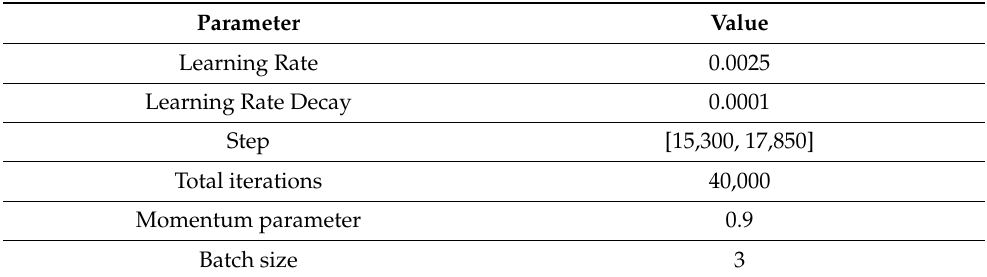
Table 2. Details of the training